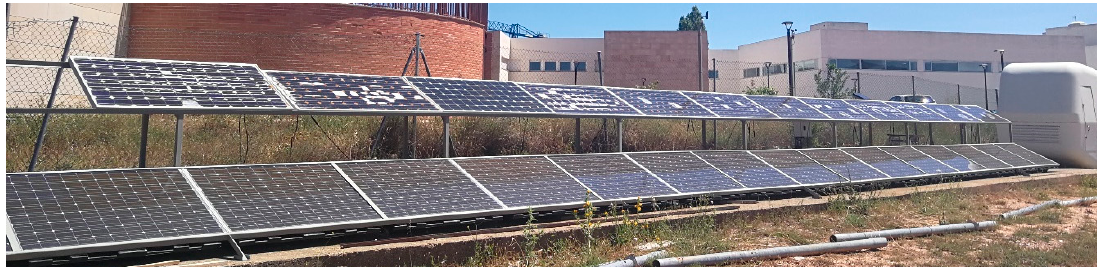
Figure 5. PV field of the Campus Duques de Soria of the University of Valladolid in Soria, Spain. Solar irradiance has been taken from ATERSA 4-20mA Compen solar cell, which registers the irradiance level every minute. The ambient temperature has been taken from Advanticsys CO 2 , temperature and humidity sensor, which registers the temperature every hour. All this information is registered in the ADVANTICSYS PV plant data logger, model